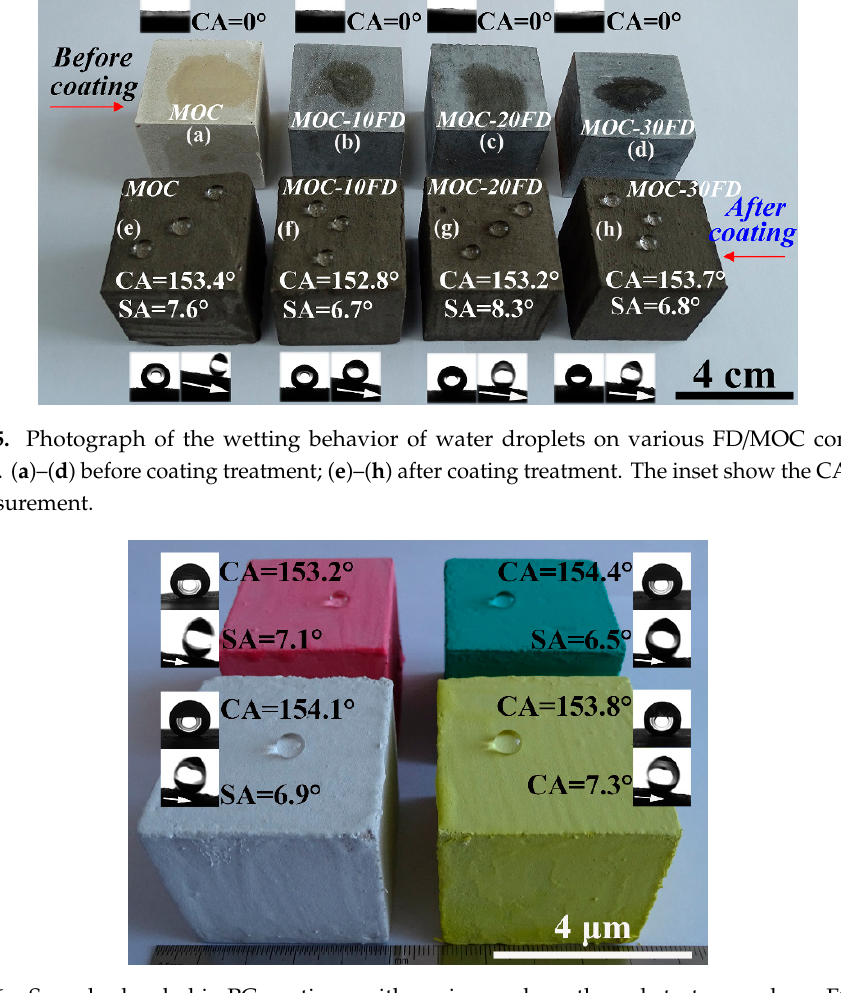
Figure 6. Superhydrophobic PC coatings with various colors, the substrates used are FC / MOC composites containing 30 wt.% FD.